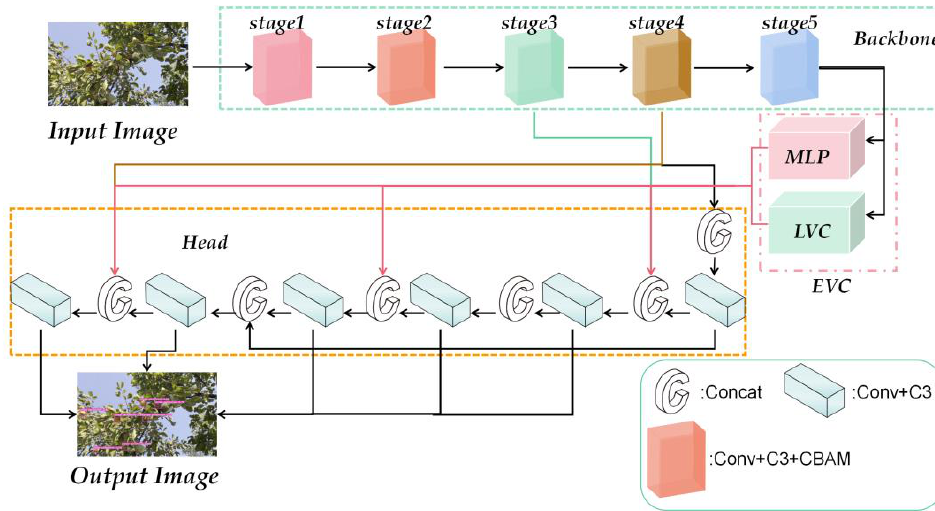
Figure 11. YOLOv5 improved model structure.